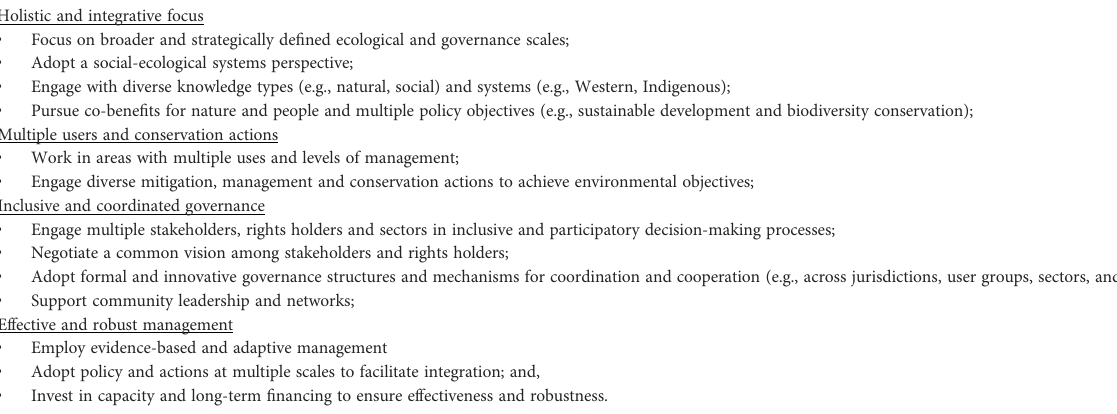
TABLE 1 De fi ning characteristics of integrated landscape or seascape approaches to conservation. Characteristics of integrated landscape or seascape approaches to conservation Holistic and integrative focus (cid:129) Focus on broader and strategically de fi ned ecological and governance scales; (cid:129) Adopt a social-ecological systems perspective;